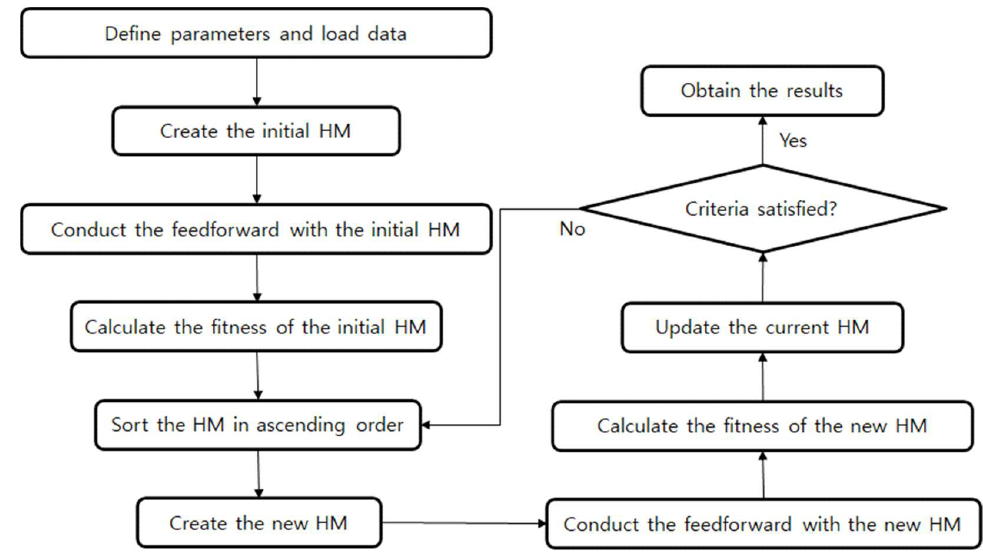
Figure 4. Calculation flow of the MLPHS.